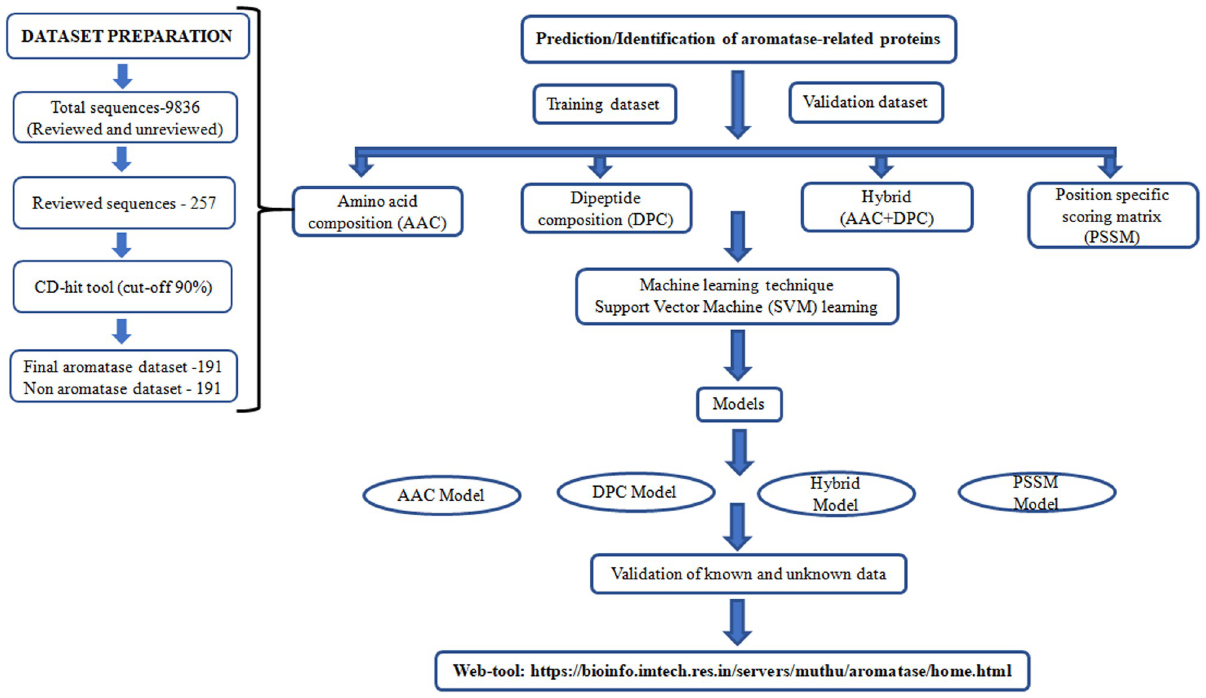
Fig 6. Flow chart for developing SVM method to predict aromatase-related